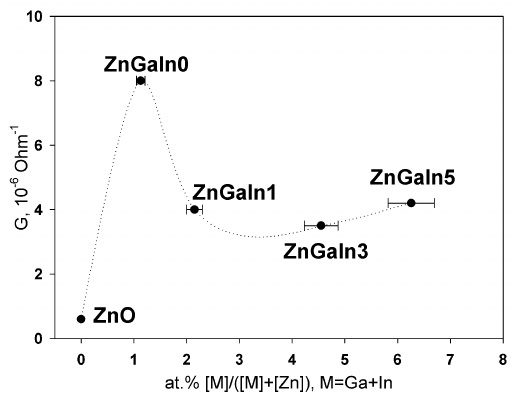
Figure 2. The dependence of thick films conductance G as a function of donor impurity.